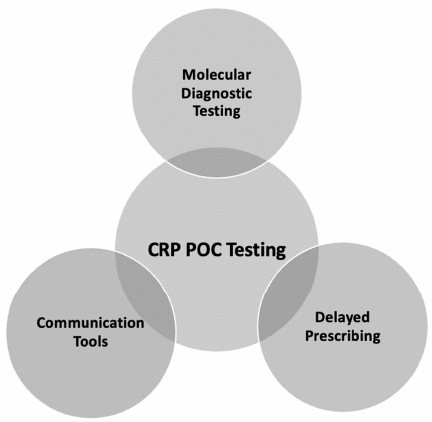
Figure 3. Strategies to reduce antibiotic over-prescription.